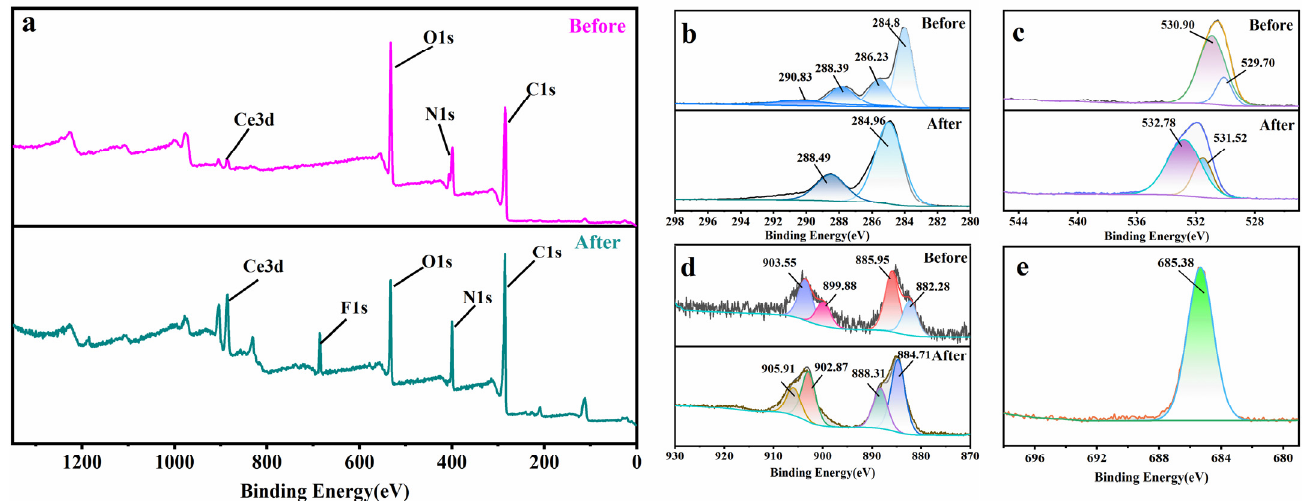
Figure 4. XPS spectra showing ( a ) survey spectra, and ( b ) C1s, ( c ) O1s, ( d ) Ce3d, and ( e ) F1s showing fi ne spectra of Ce-H3TATAB-MOFs.